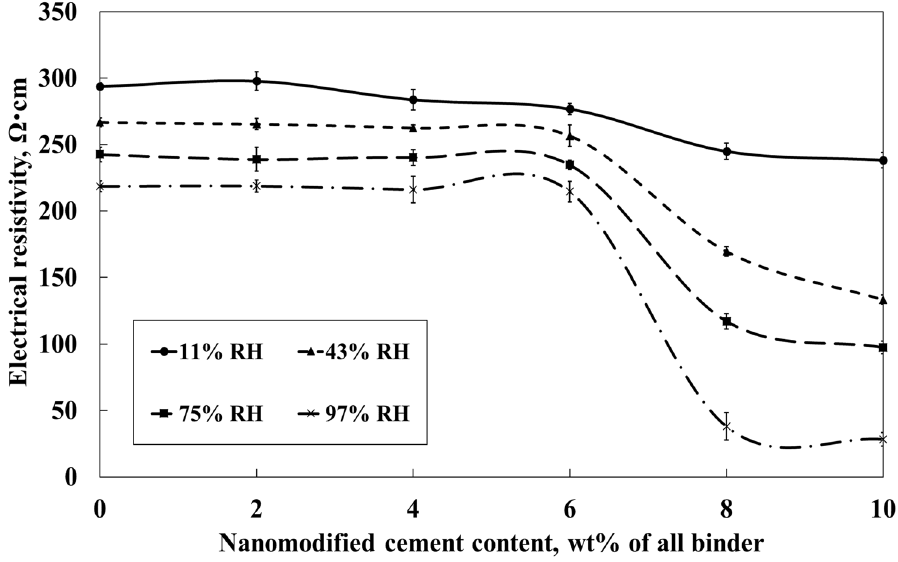
Figure 6. Effects of humidity and amount of nanomodified Smart cement content on the measured electrical resistivity. Error bars represent standard errors.